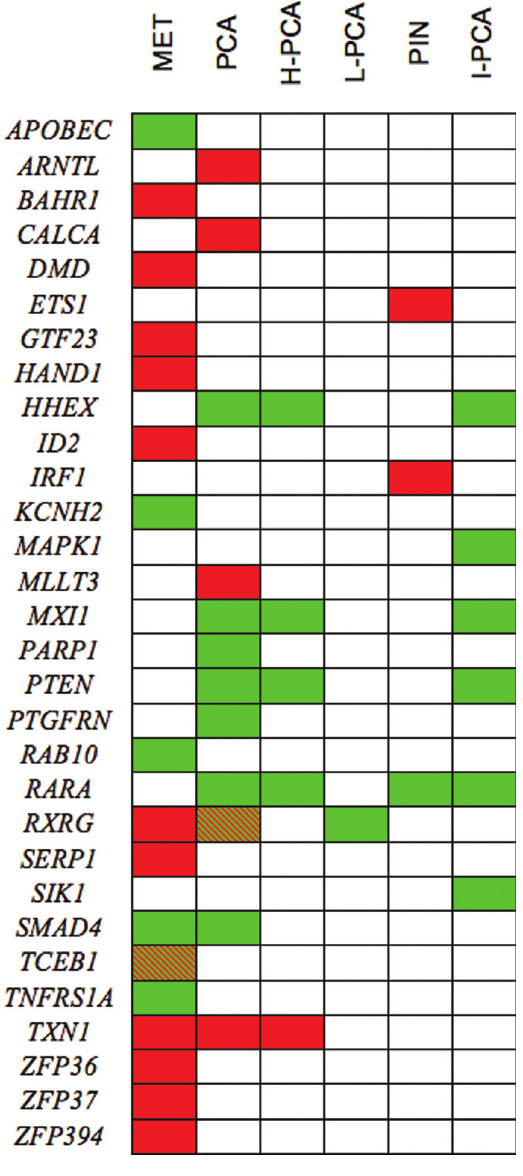
Figure 3 - Association of frequently amplified (red), deleted (green) or both (hatched) chromosomal regions harboring 30 of the selected TF/TR in metastatic prostate cancer (MET), prostate cancer (PCA), high grade PCA(H-PCA),lowgradePCA(L-PCA),prostateintraepithelialneoplasia (PIN),andintermediateriskPCA(I-PCA).BasedonKim etal .(2007)and Ishkamian et al .